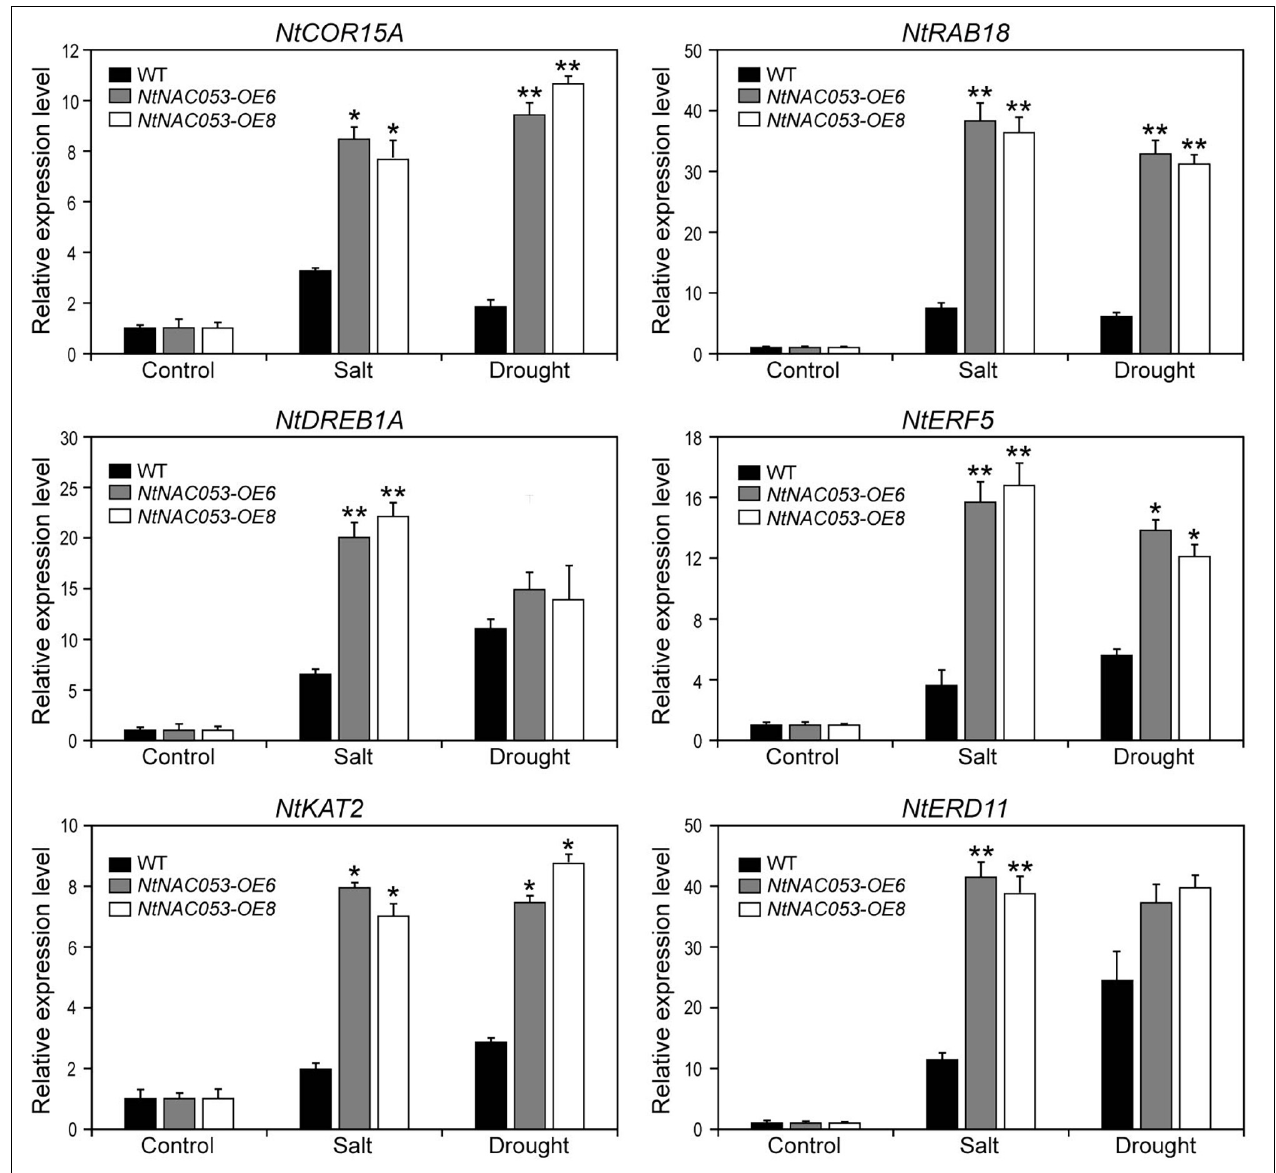
FIGURE 9 | Expression of stress-related genes in overexpression lines and wild-type tobacco under salt and drought stresses. The ratios of gene expression levels were calculated relative to the control, respectively. WT, wild type. The data were means ± SD from three independent replications. * p < 0.05, ** p < 0.01 ( t